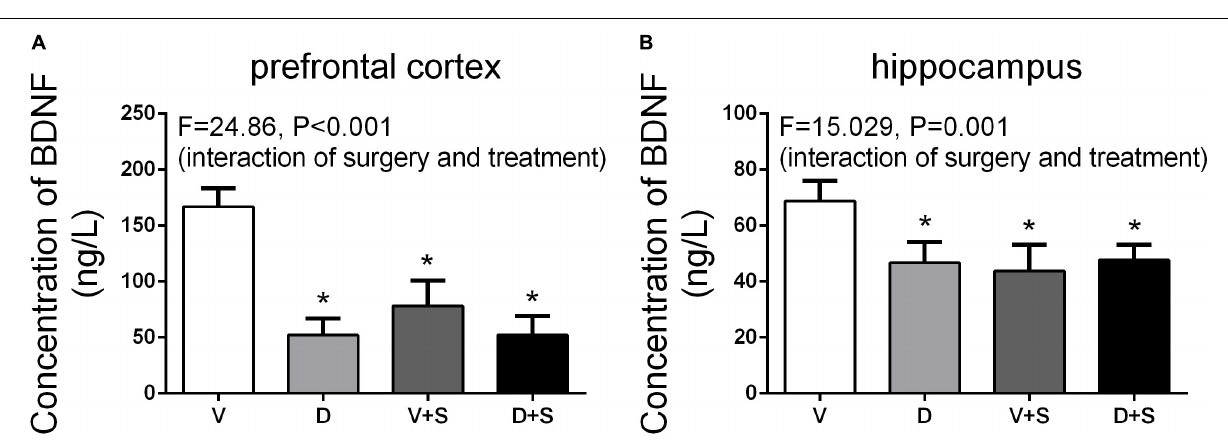
FIGURE 10 | Brain-derived neurotrophic factor (BDNF) levels in the prefrontal cortex (A) and hippocampus (B) at 3 weeks postoperatively. The data are presented as the means ± SEM for each group ( n = 5 per cohort). * p < 0.05 compared to Group V, # p < 0.05 compared to Group V +